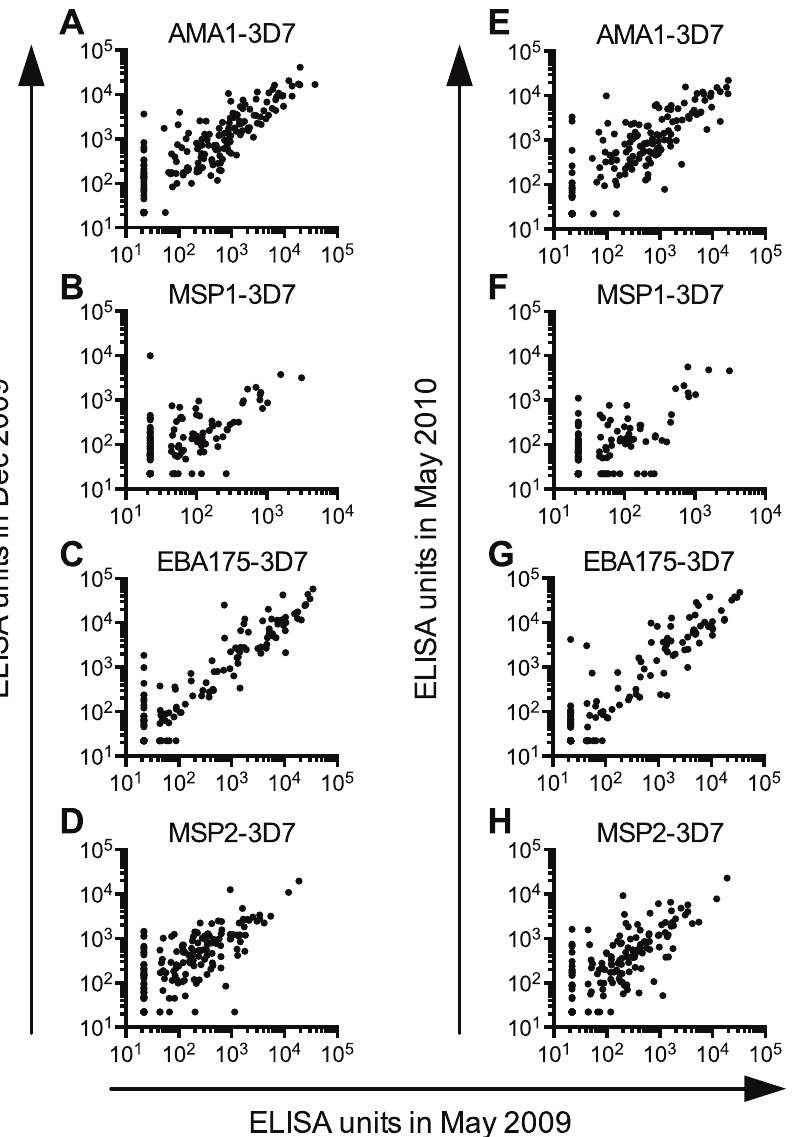
Figure 6. Significant correlations between merozoite antigen-specific IgG levels at three time points. IgG levels in May 2009 are plotted against IgG levels in December 2009 (A–D) and May 2010 (E–H). Each dot represents data from a single child. Plasma IgG levels to four merozoite antigens (A and E, AMA1-3D7; B and F, MSP1-3D7; C and G, EBA175-3D7; D and H, MSP2-3D7) are correlated. All responses below the limit of detection (44 ELISA units) were assigned a value of 22 ELISA units. All correlations shown are significant (p , 0.001 by Spearman rank